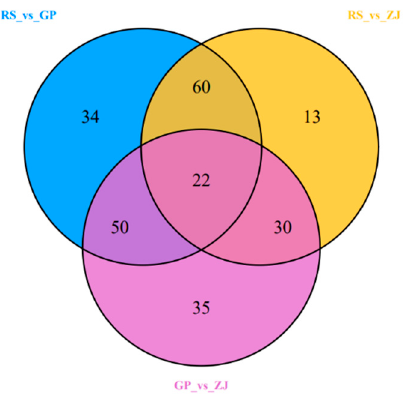
8 of 19 Figure 5. Volcano plots: ( a ) RS vs. GP; ( b ) GP vs. ZJ; ( c ) RS vs. ZJ. The green dots in the plots illus- trated that the differential metabolites were significant and down-regulated, while the red dots il- lustrated that the differential metabolites were significant but upregulated, and the black dots illus- trated that the metabolites could be detected but not significantly different. Venn diagram analysis, which is based on differential metabolites that were signifi- cantly different in the three comparative groups, shows the prevalent or unique metabo- lites present in the group. The abovementioned graph shows that a total of 244 metabolites that existed in at least two groups were shown to clearly change in content (Figure 6). Meanwhile, there were 22 significantly different metabolites shared among the three groups, and the comparison groups had unique differential metabolites (Table 3). The heatmap of the different metabolites commonly found in the three comparison groups (Figure 7b) also showed differences. Thus, the differential metabolites can be clearly dis- tinguished between GP, RS, and ZJ samples. We found that the three groups of signifi- cantly different metabolites were mainly from flavonoids, lipids, and amino acids and derivatives (Figure 7a). The obtained results showed that compared to the GP and ZJ groups, the flavonoid content in the RS group significantly increased. Furthermore,